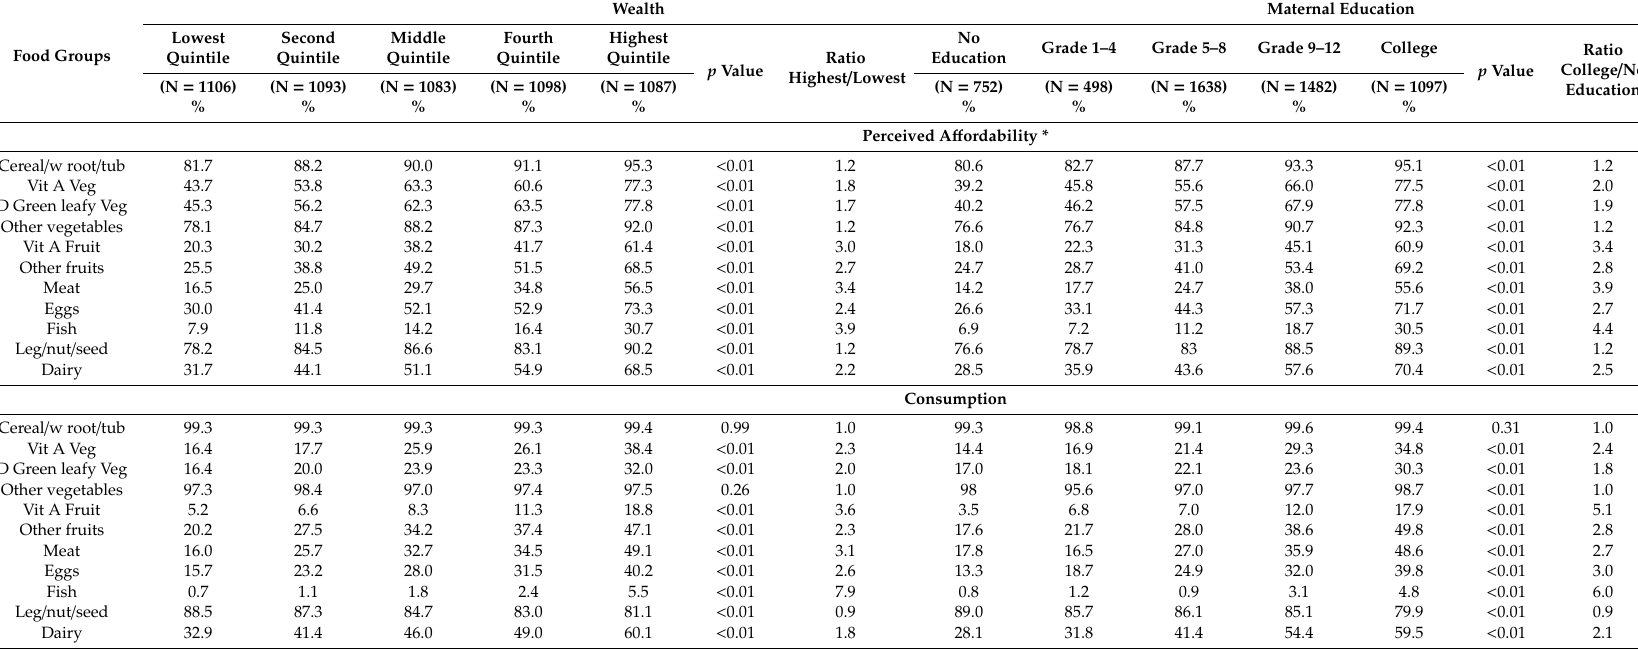
Table 3. Perception of a ff ordability and consumption of family food by socioeconomic resources, Addis Ababa,